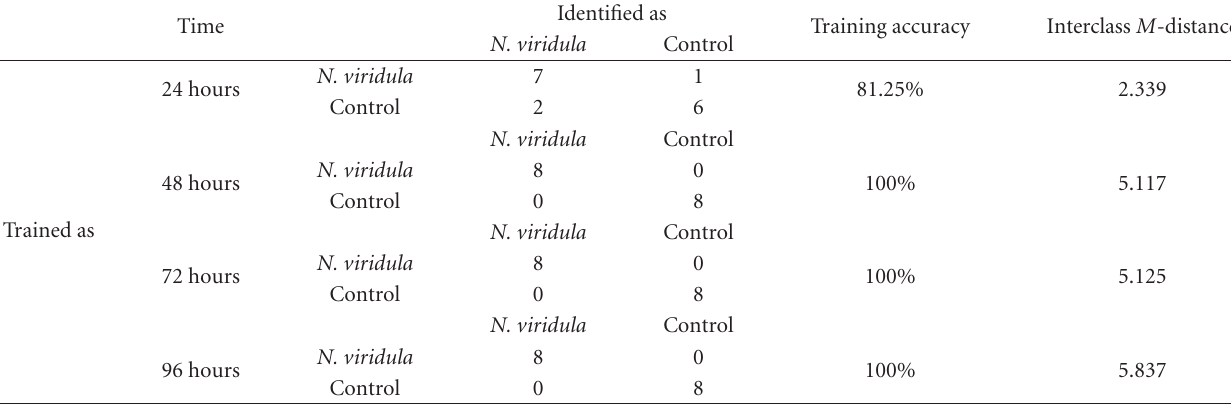
Table 2: Cross-validation, training accuracy, and interclass Mahalanobis distance of training sets based on E-nose sensor response to headspace VOC emissions from 8 unexposed (control) bolls and 8 bolls exposed to Nezara viridula